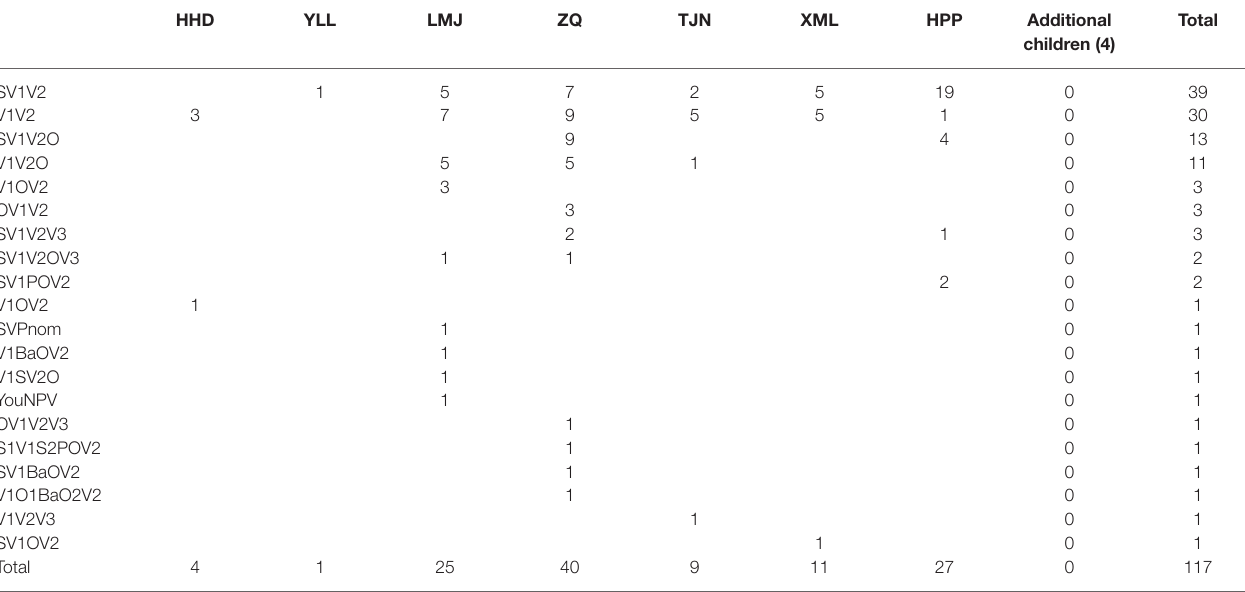
TABLE 7 | Frequency of Multiverb sentences used by 20 m-matched children with ASD. HHD